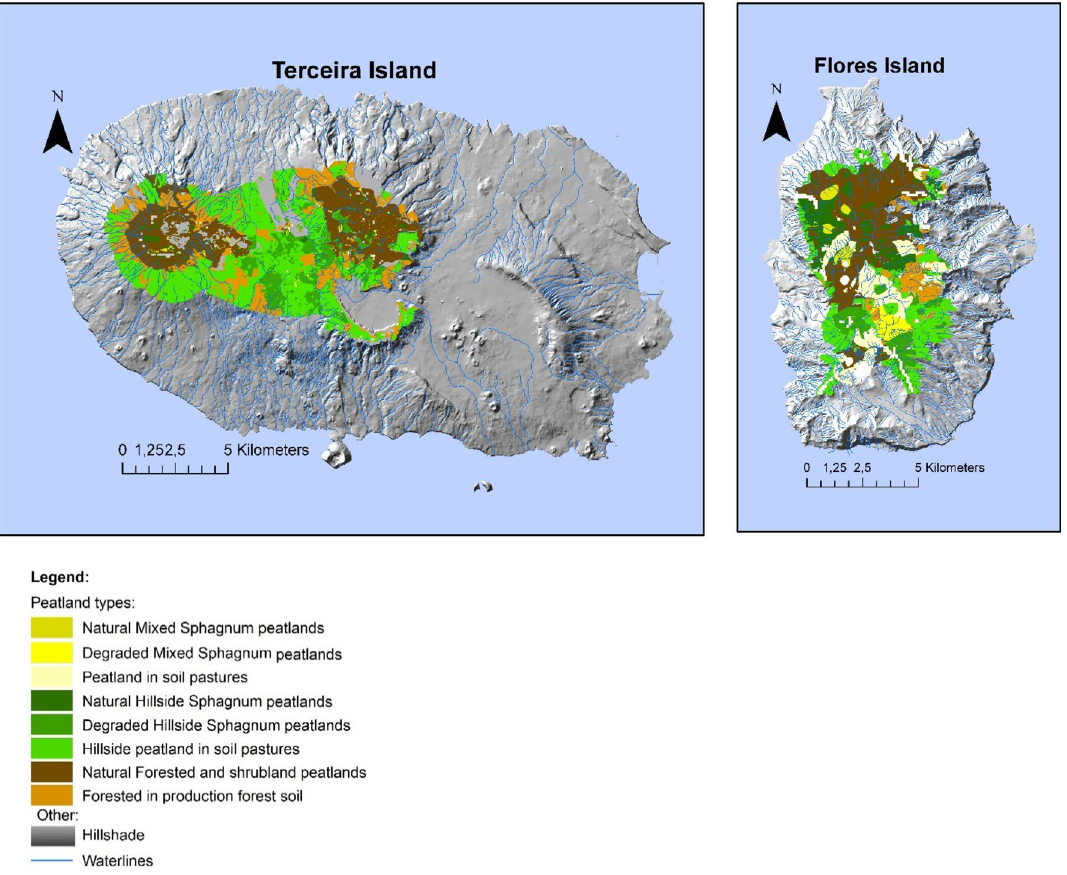
Fig. 4 Actual distribution of peatlands defined for Terceira and Flores Islands by the level of naturalness (natural, degraded or peat soil when transformed into pasture or forest production). Cartography in ArcGIS 10.6